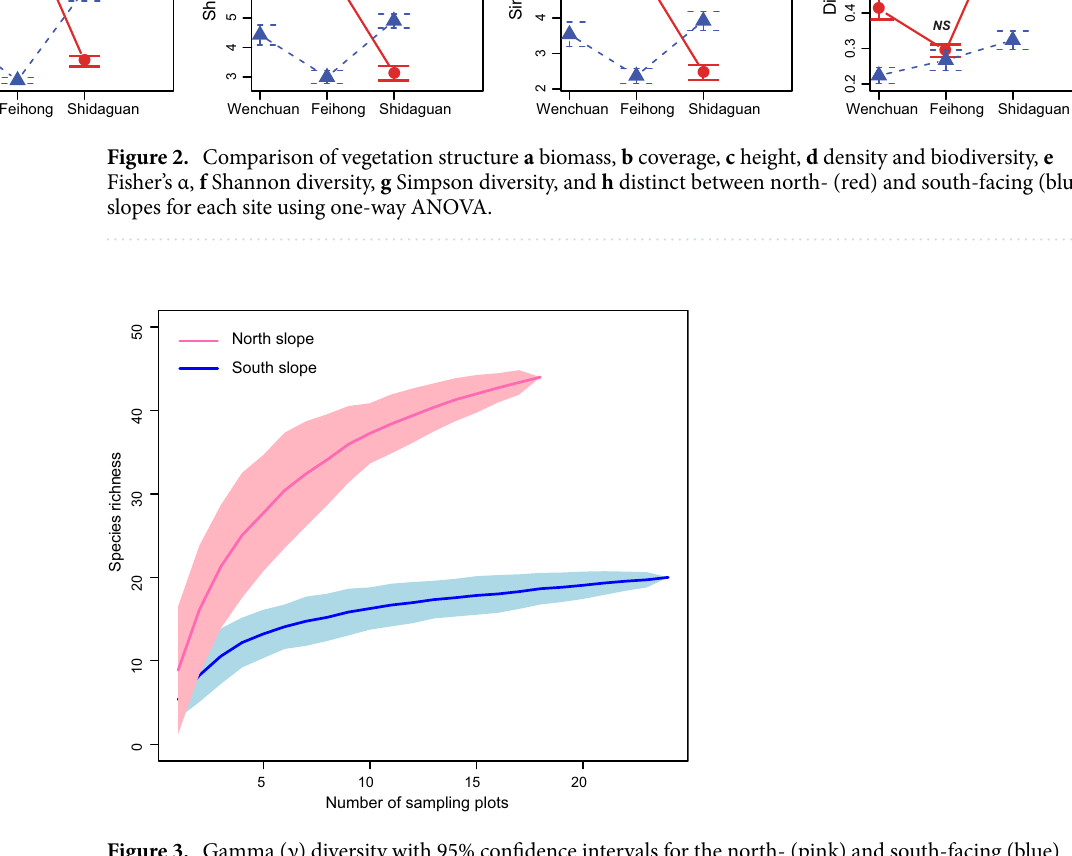
For the whole valley scale, all α diversity metrics were significantly higher on north-facing slope (Fisher north = 2.68 ± 0.34, Fisher south = 1.85 ± 0.19, p = 0.002; Shannon north = 5.94 ± 0.65, Shannon south = 4.21 ± 0.22, p = 0.006; Simpson north = 4.75 ± 0.57, Simpson south = 3.35 ± 0.21, p = 0.013); however, the pattern at Shidaguan was inconsistent with the general pattern and other sites where all α diversity metrics were significantly higher on south-facing slope (Table 2, Fig. 2e–g). Comparison of local floristic distinctiveness (Distinct) showed significantly higher value on north-facing slope at the whole valley scale (Distinct north = 0.50 ± 0.05, Distinct south = 0.28 ± 0.02, p = 1.06E−05) but not Fei- hong, where no significant difference was found between the opposite slopes ( p = 0.896) (Table 2, Fig. 2h). At landscape scale, the multivariate woody β diversity was significantly higher on north- than south-facing slope (β